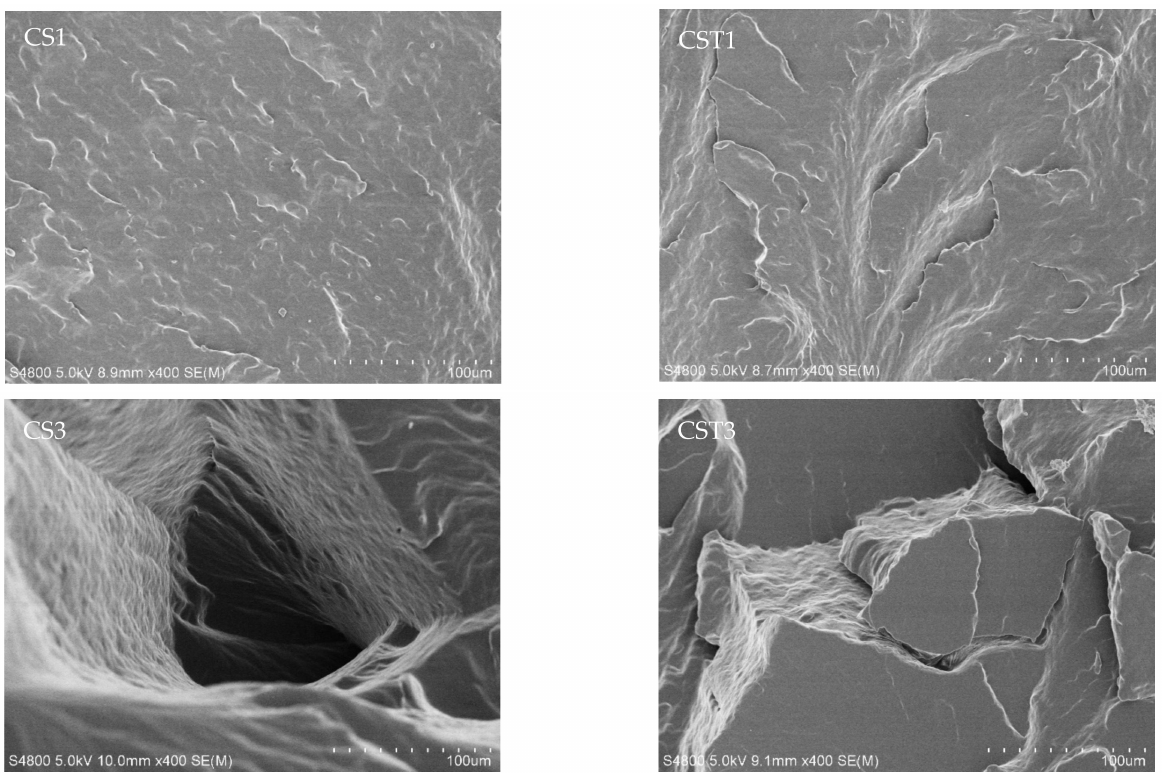
Figure 8. The cross-sectional SEM images of the tensile test